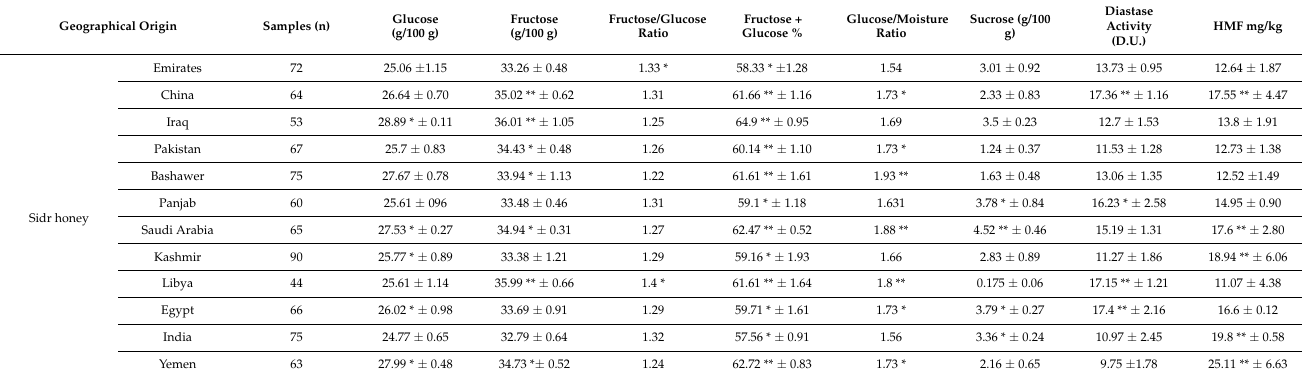
Table 4. Glucose, fructose, sucrose, diastase activity and HMF levels in different Sidr honey samples.